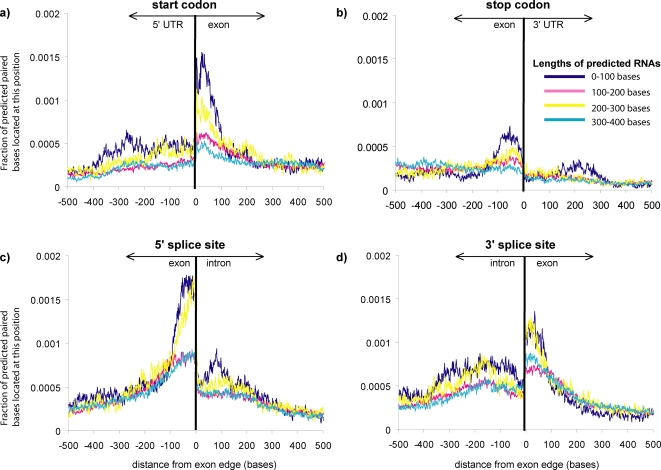
Predicted base pairs are preferentially found just inside exon boundaries.Locations of predicted base pairs were tabulated separately for four length categories of motifs (dark blue = 0–100 base long motifs, pink = 100–200 bases, yellow = 200–300 bases, light blue = 300–400 bases). These locations of predicted base pairing are plotted near the a) start codon; b) stop codon; c) 5′ splice site; and d) 3′ splice site. Predicted base-pairs involved in secondary structure are most common just inside exon boundaries, and many of these base-pairs are contained in short predicted secondary structures (0–100 bp).